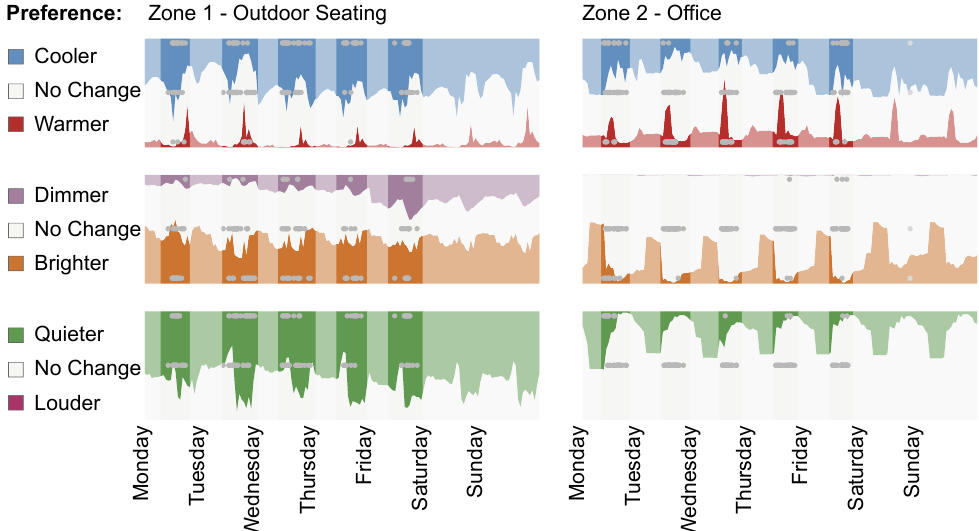
Figure 9. Comfort prediction for two zones for an average occupant over a week. The grey circles indicate votes that were given for each category, and the shaded-out sections indicate times where no data were present. These time-series predictions can be used to detect anomalies, such as the mid-day peak for a warmer preference for the office , or the general discomfort in the outdoor seating area. Note that there was an absence of data in these zones between the hours of 22:00–7:00, and on the weekend. This lack of data caused inaccurate predictions as seen in the square-shaped peaks in the office